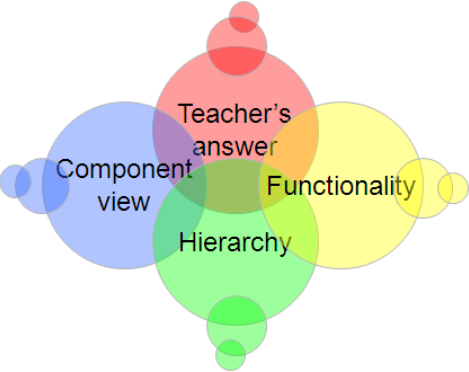
Figure 1. Different perspectives for manufactron